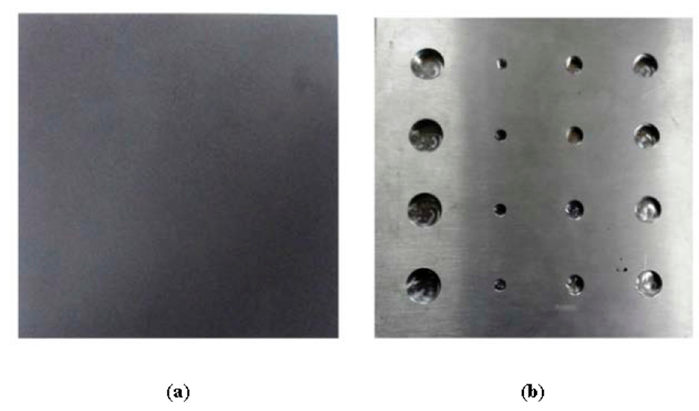
Figure 4. Photographs of the sample used for the study, ( a ) front side with black paint and ( b ) rear side with flat-bottomed holes.